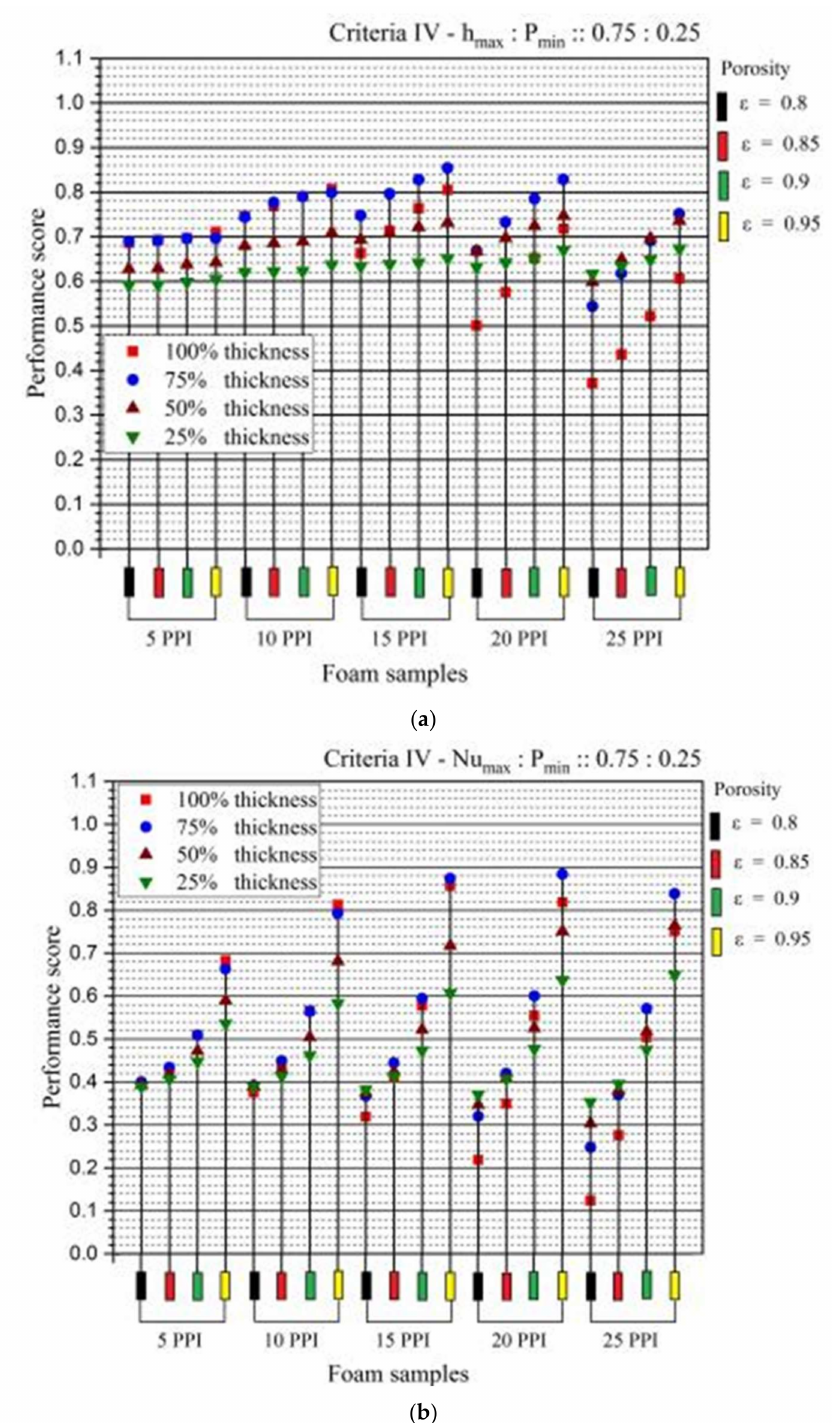
Figure 13. ( a ) Criteria IV (h max :P min ). ( b ) Criteria IV (Nu max :P min